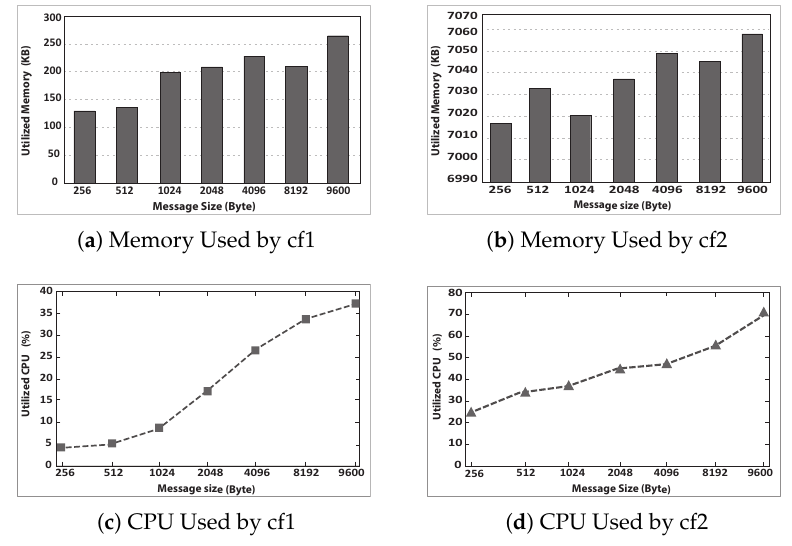
Figure 22. Resource use of cf1 and cf2 on Raspberry